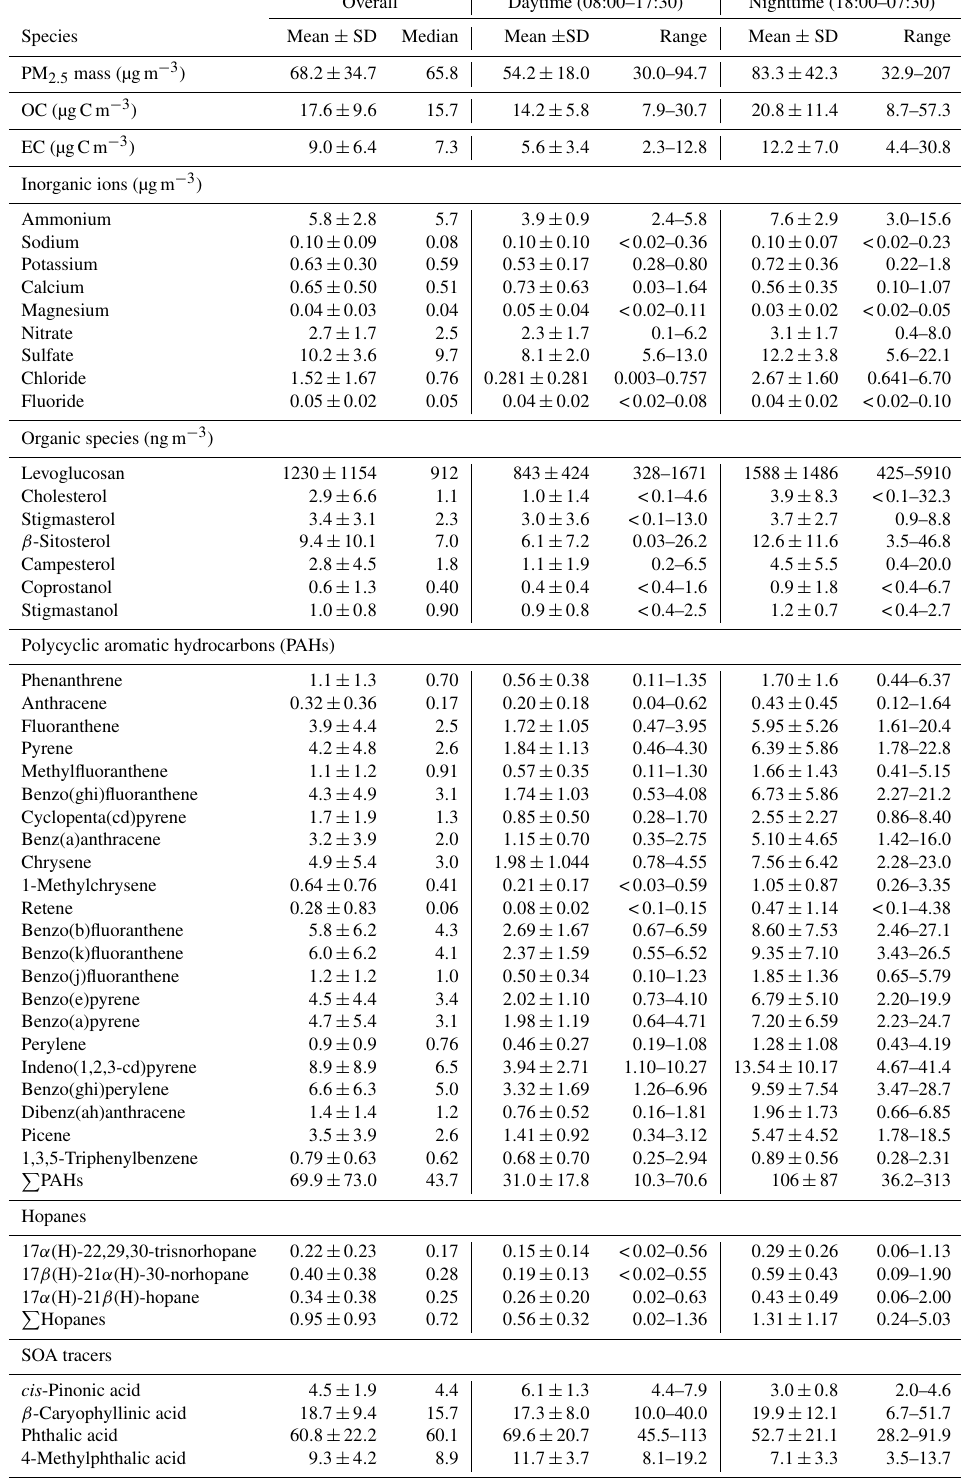
Table 5. PM 2 . 5 mass concentrations, OC, EC, inorganic ions, and organic species measured at Bode in the Kathmandu Valley. Overall Daytime (08:00–17:30) Nighttime